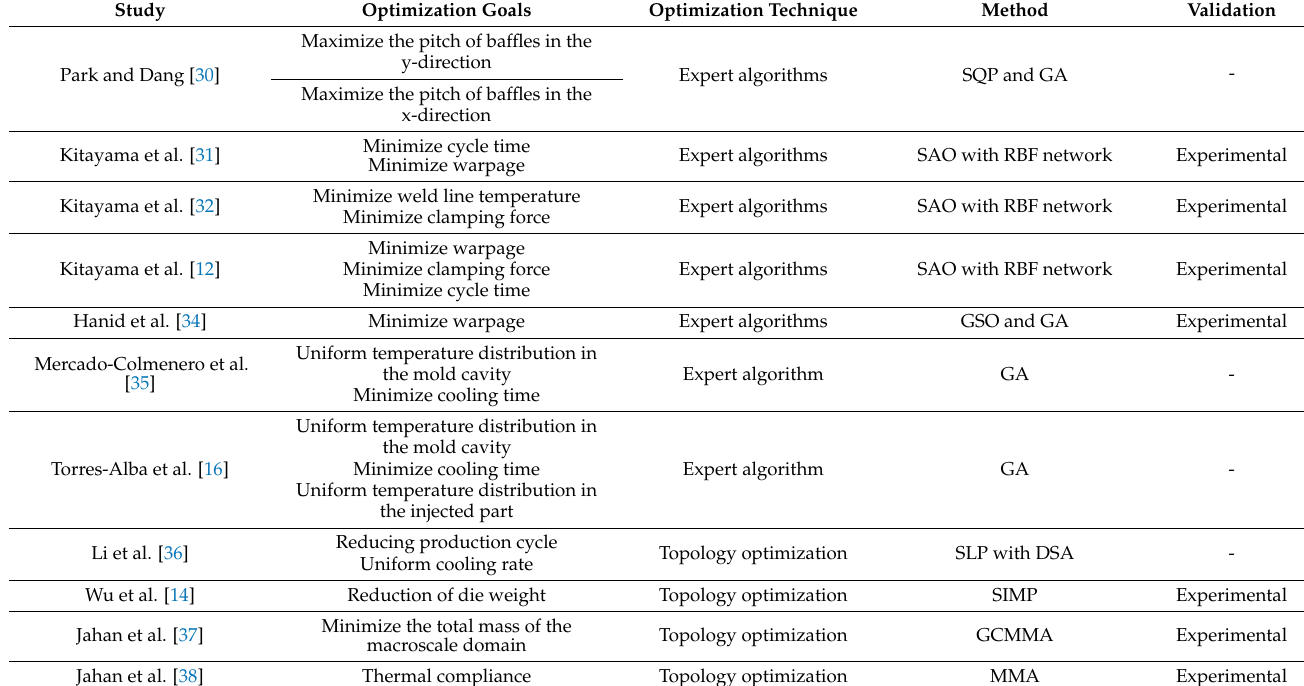
Table 2. Summary of the optimization